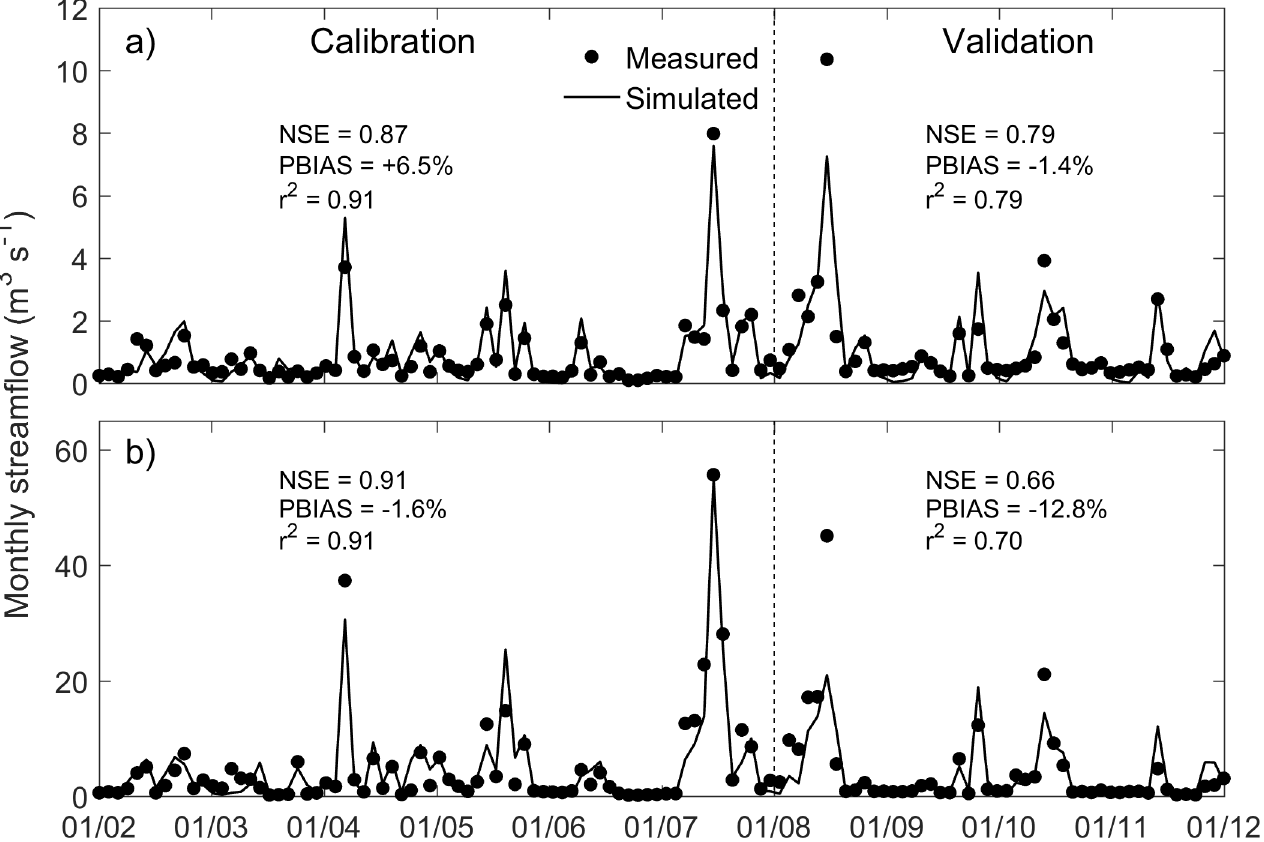
Fig 3. Comparisonof observedand simulatedmonthly mean streamflow at Enid, OK (a) and Lovell,OK (b) duringsix years of calibration (2002– 2007) and four years of validation(2008–2011).